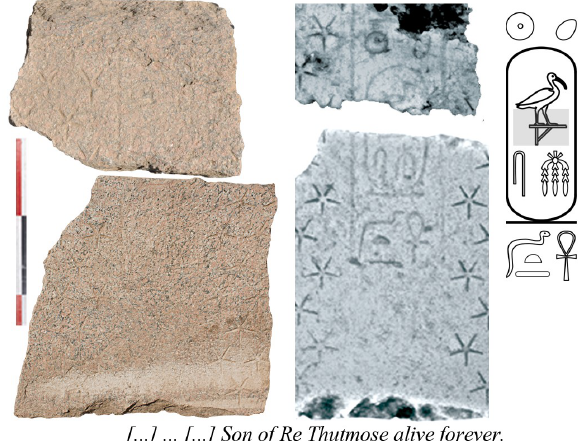
Figure 9: Depth maps application on architectural blocks: the case of ceiling fragments from the Central Bark Shrine in